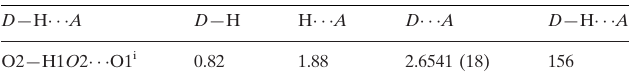
Hydrogen-bond geometry (A˚ , (cid:3)